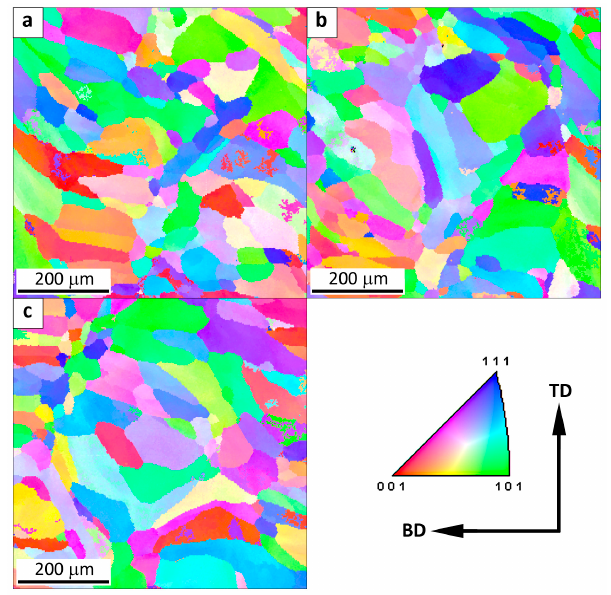
Figure 5. The map of crystallographic orientation in a sample obtained at a medium cooling rate: ( a ) at the substrate (2.1 × 10 4 K/s), ( b ) half the height of the sample (1.6 × 10 4 K/s) and ( c ) top of the sample (1.6 × 10 4 K/s). The spatial orientation of the sample is presented with respect to the building direction (BD) and transverse direction (TD).